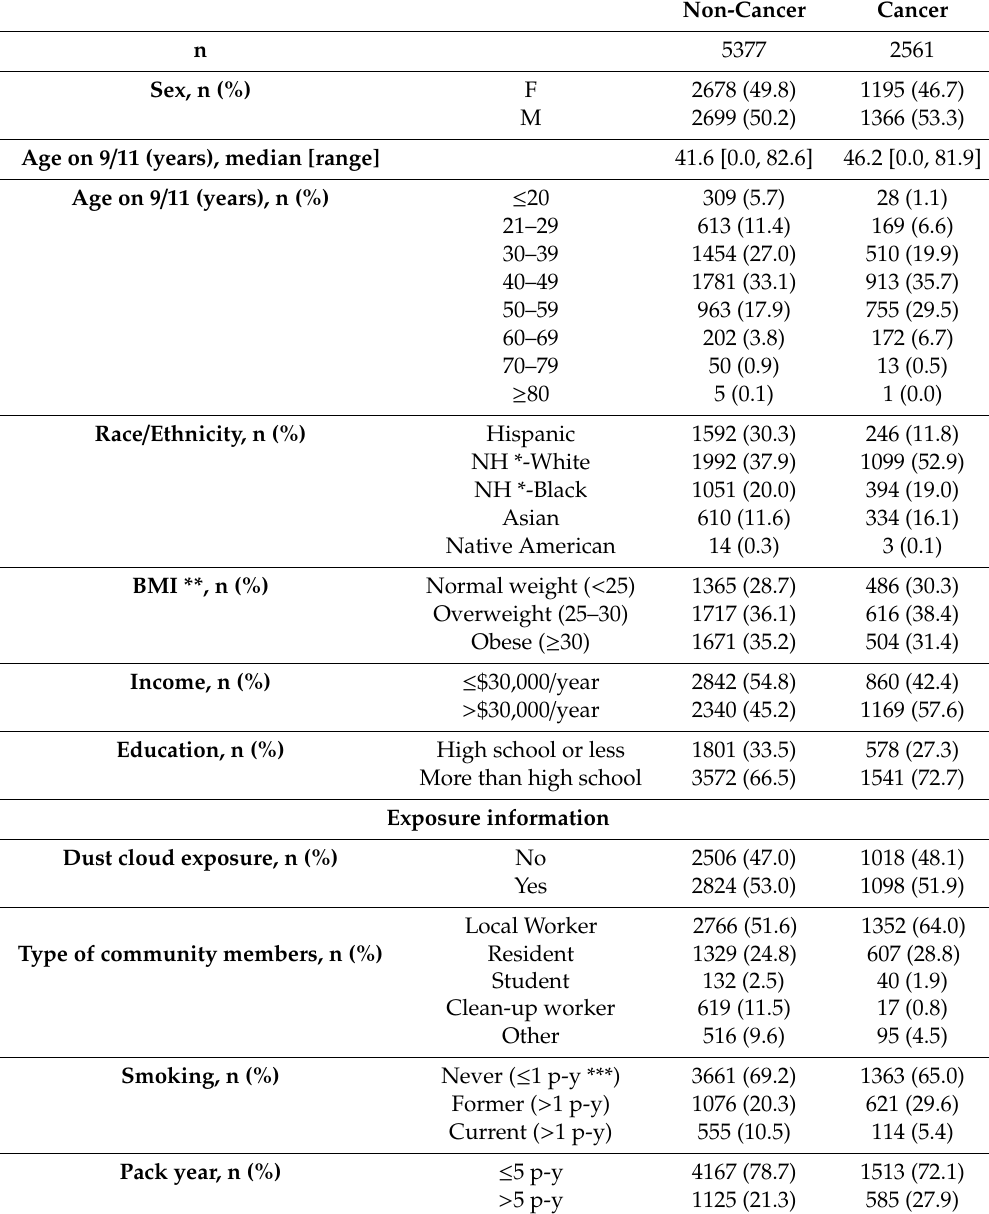
Table 1. Characteristics of patients with / without cancers at enrollment in the WTC